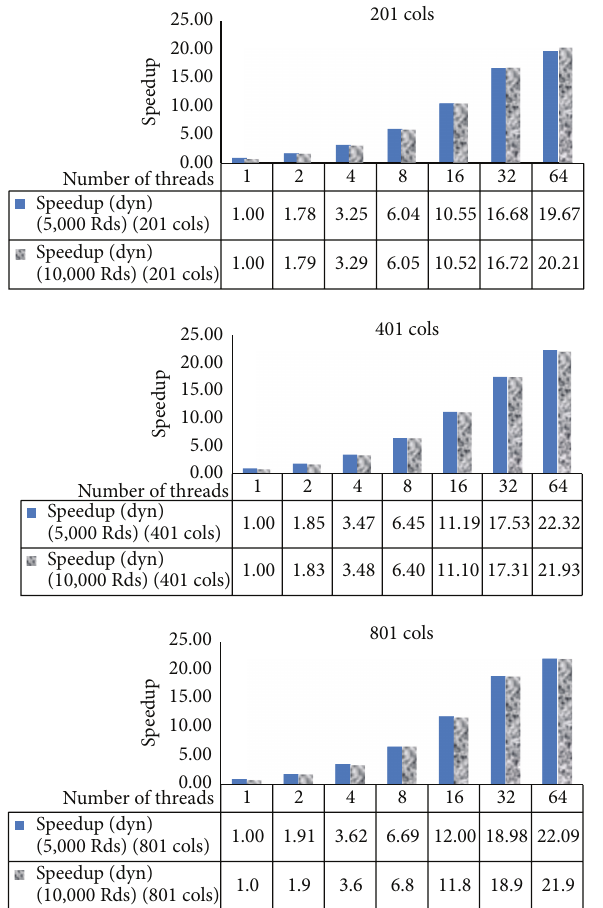
Figure8:Thespeedupforthecasenumberofcolumns,201,401,and 801 with the dynamic schedule varying number of iterations, 5,000 and 10,000 iterations.